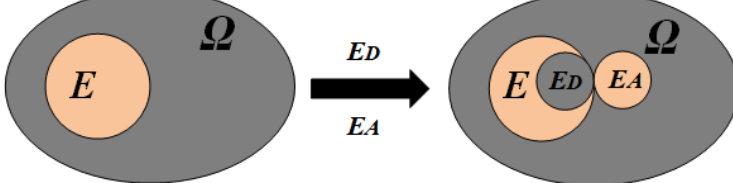
Figure 2. Edge relationship between the disguised network and the real network.